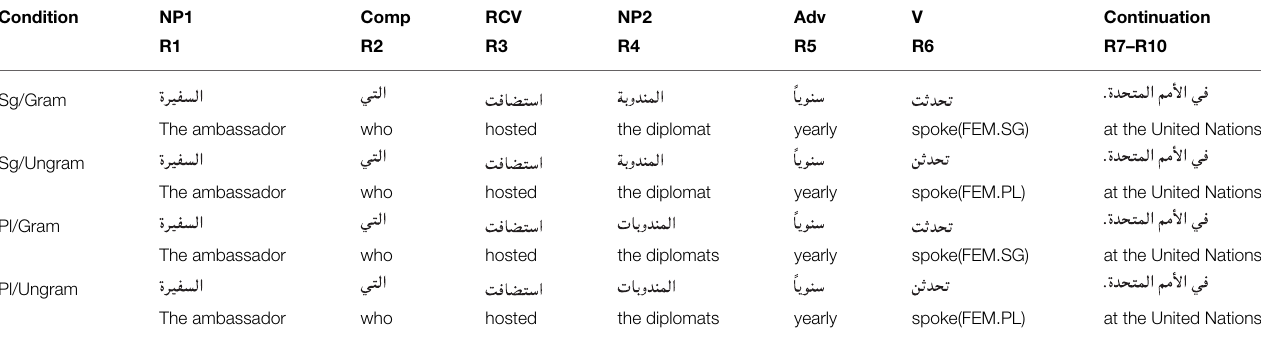
TABLE 1 | A complete item set for one sentence for the experiment.